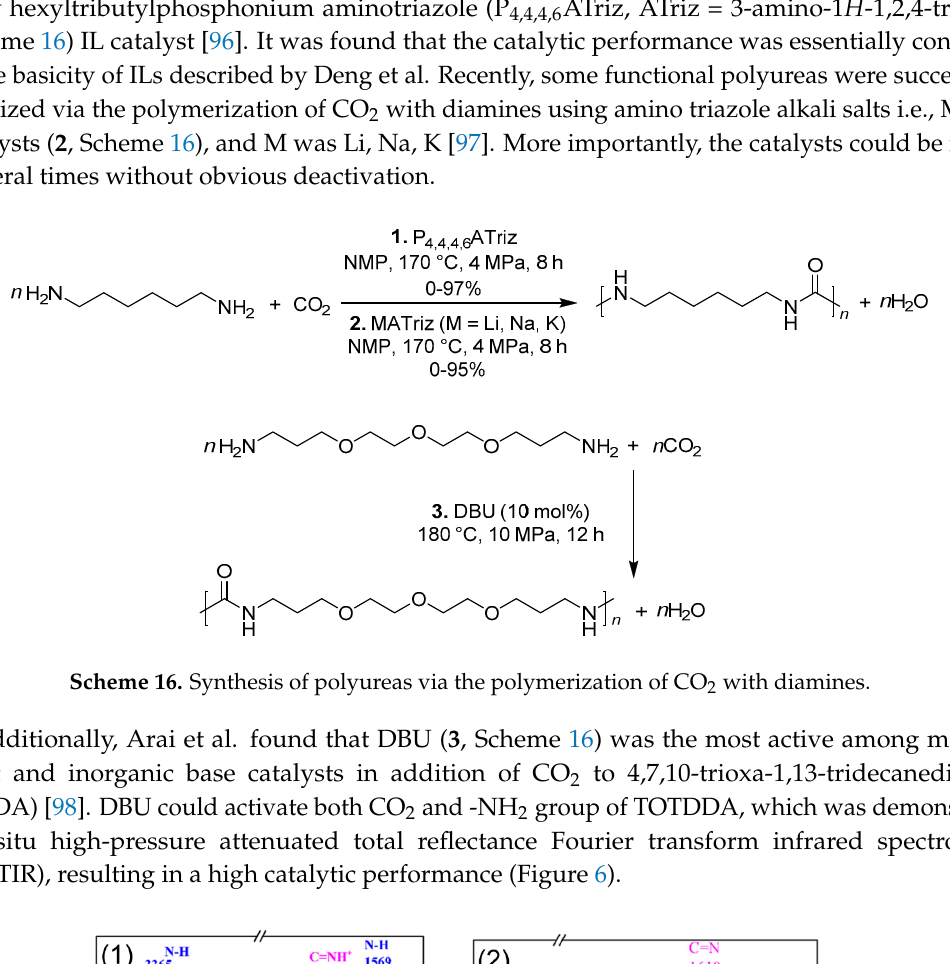
Figure 5. Various ureas by CeO 2 /NMP system. Reprinted with permission from [92] (Copyright 2015 Elsevier Inc.).